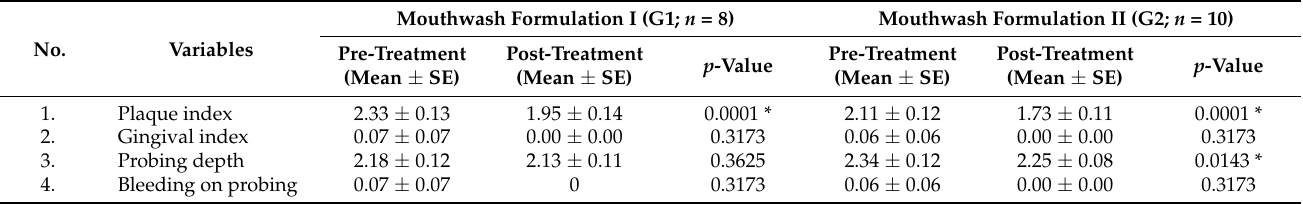
Table 5. The comparison of the plaque index, probing depth, gingival index, and bleeding on probe values of pre-and post-treatment samples of G1 and G2. * indicates the statistical significance.